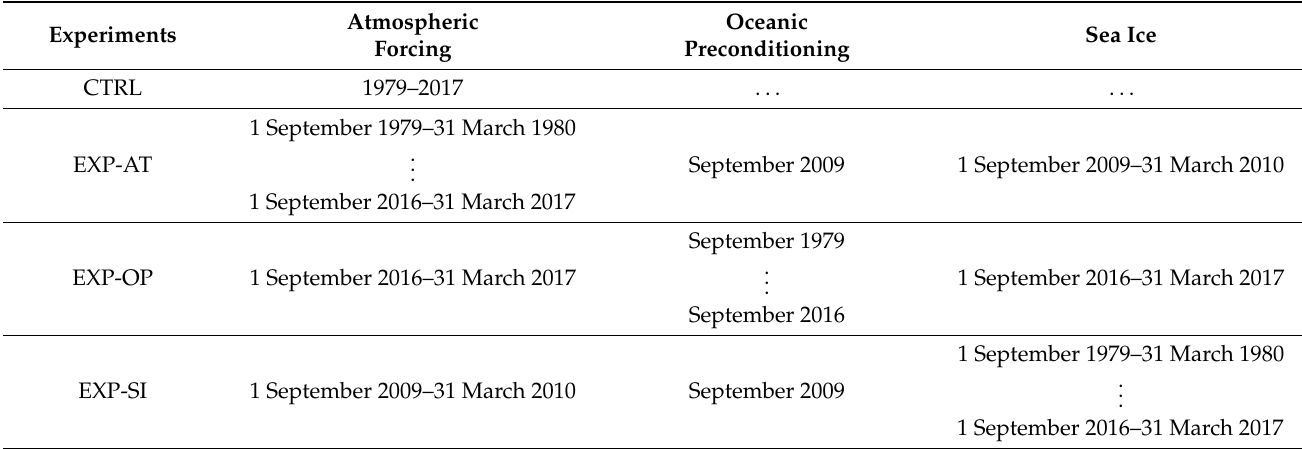
Table 1. Summary of numerical